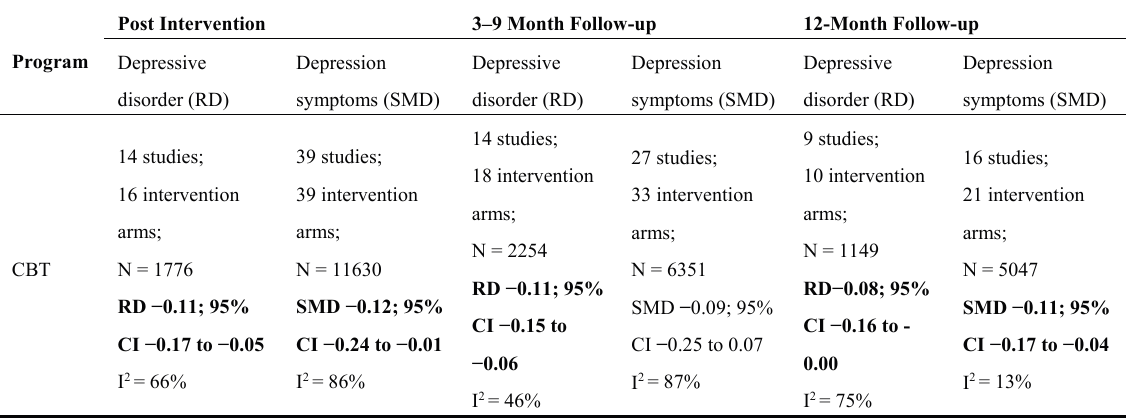
Table 3. Summary of meta-analysis results for the therapeutic approach to prevention